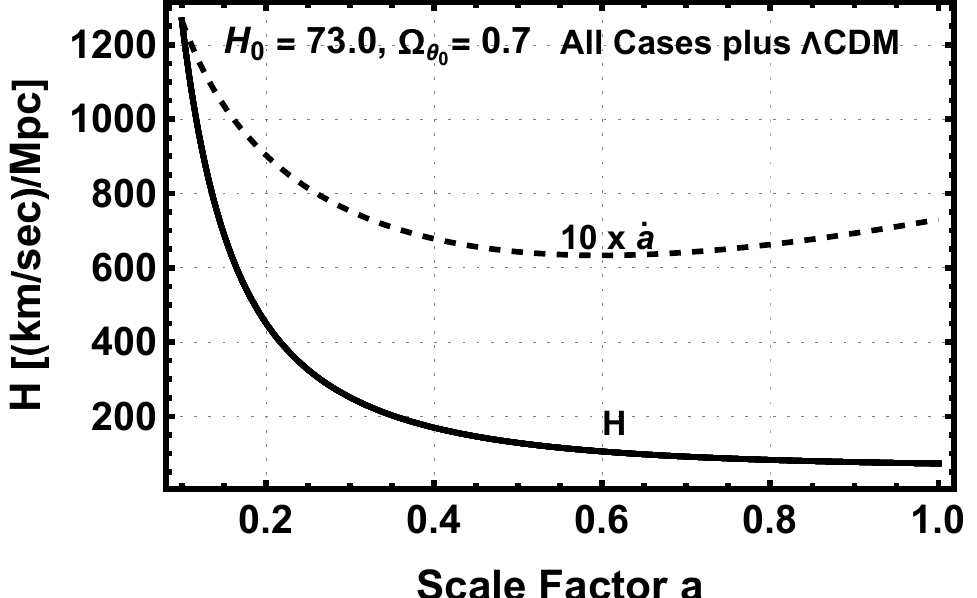
Figure 7. The figure shows the evolution of the Hubble parameter for all cases in this study and Λ CDM. The evolution of the time derivative of the scale factor is also shown in the dashed line to indicate the onset of the acceleration of the expansion of the universe. The scale of its evolution has been magnified by 10 to make it visible in the